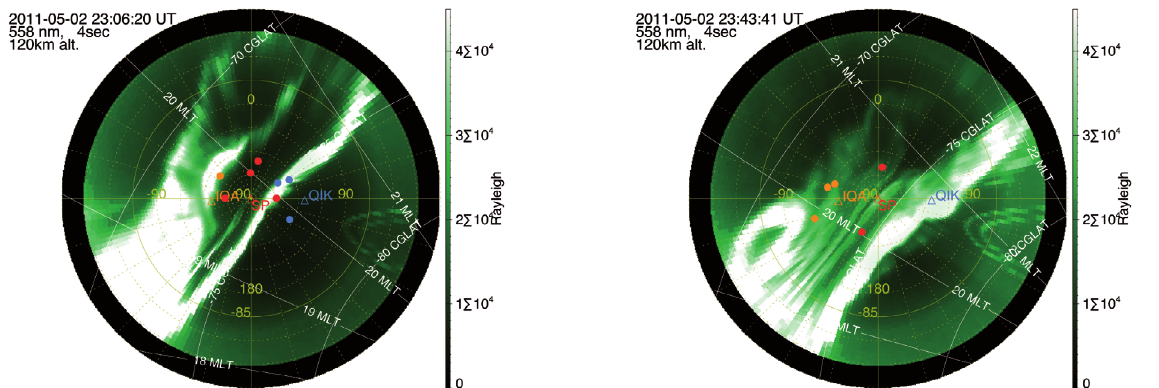
Figure 11. Mapped 557.7-nm images of an arc brightening during a substorm on May 2,